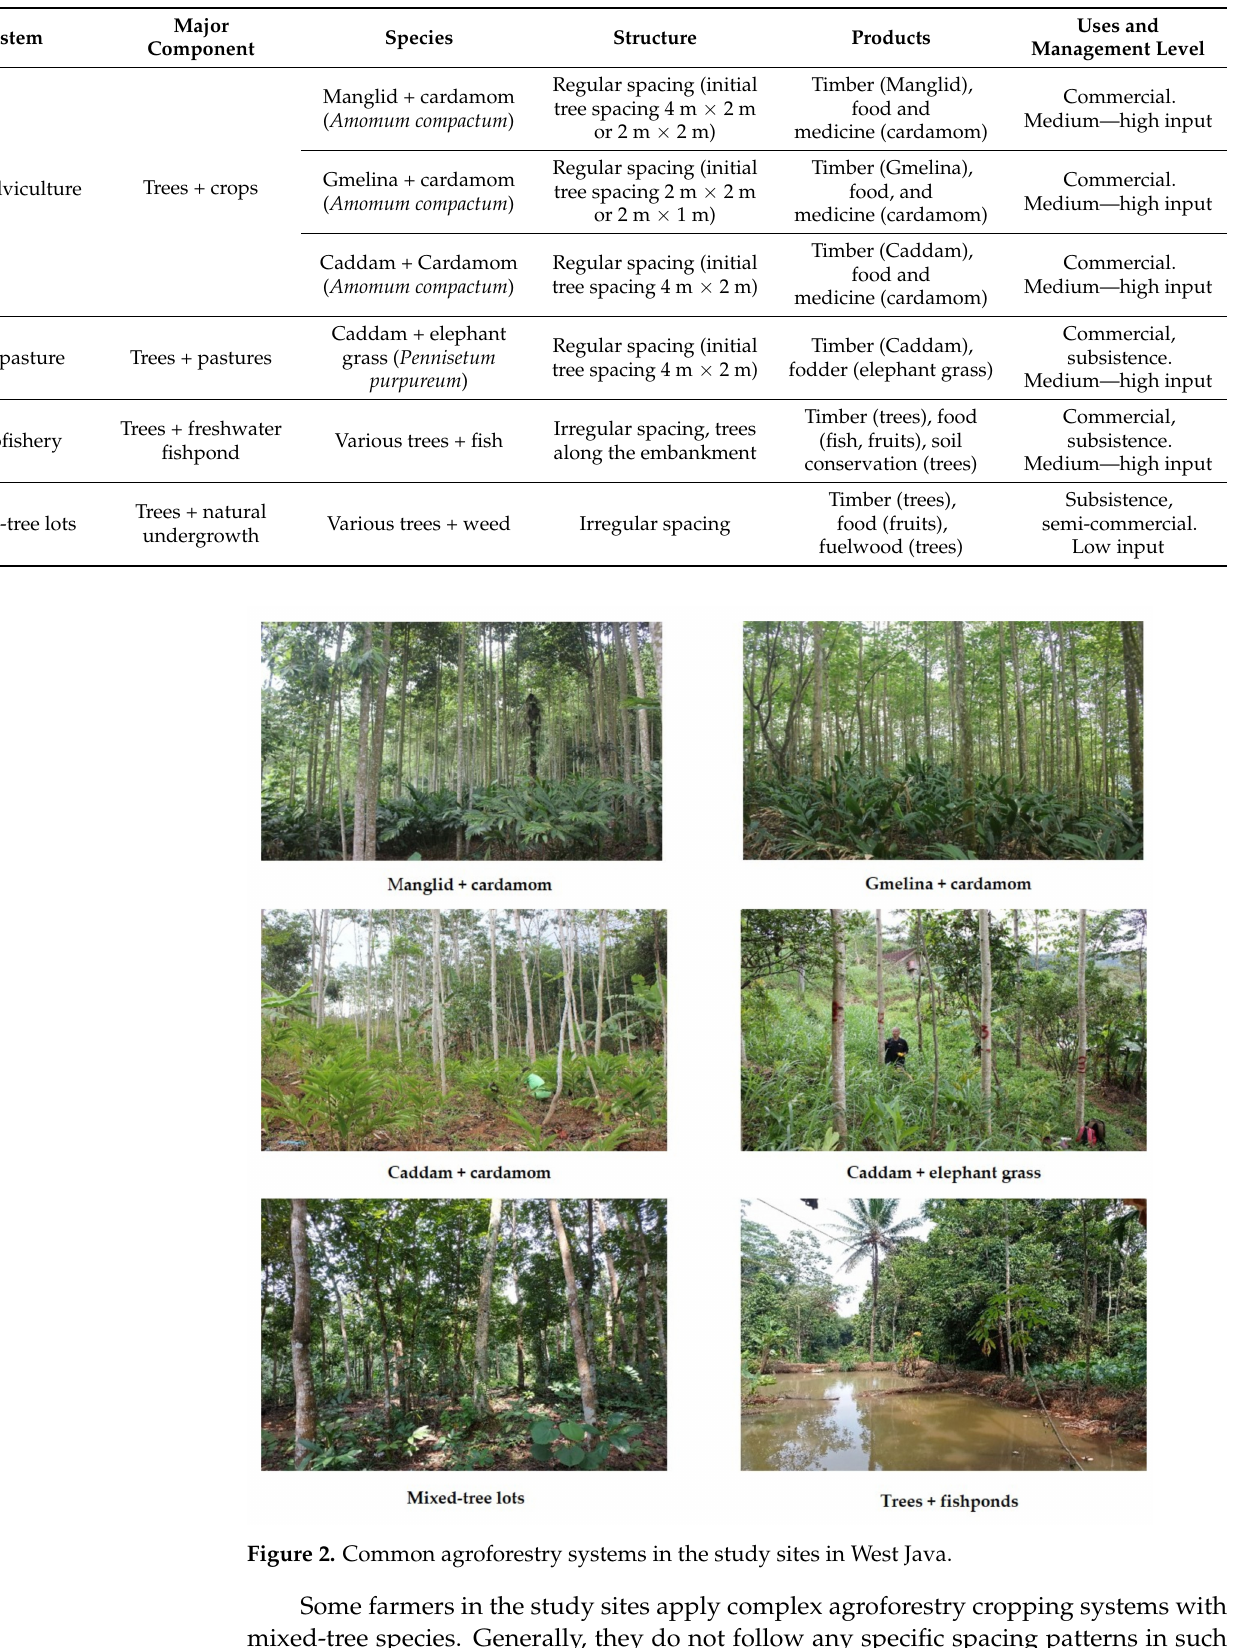
Table 2. Description of common agroforestry systems across the study sites in West Java.